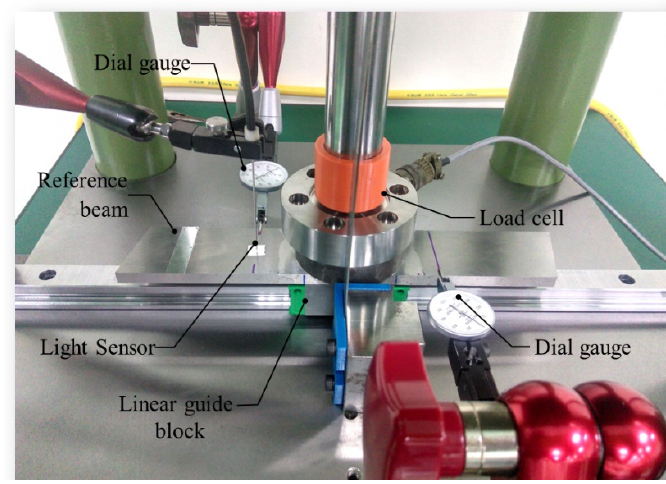
Figure 2. Experimental setup of compression test of linear guide.